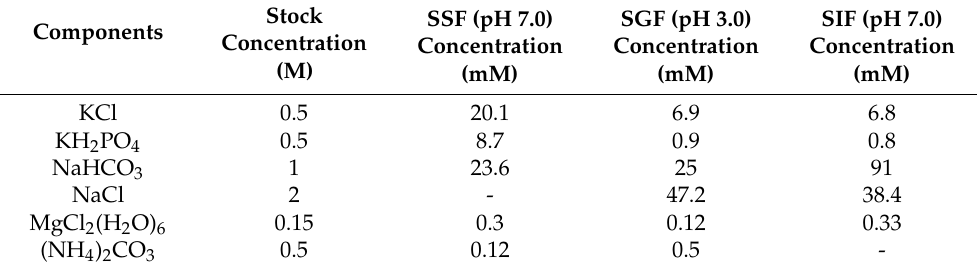
Table 1. Detailed composition of stock solutions used to prepare simulated digestive